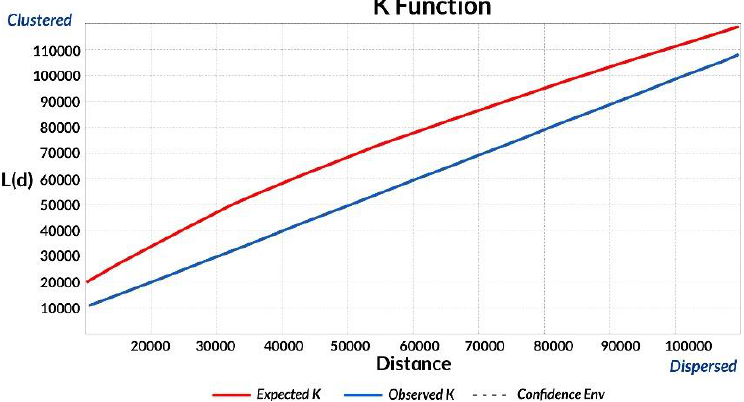
Figure 6 . The spatial pattern of land cover changes in 1990–2018, in the relation of scale. Ripley's K